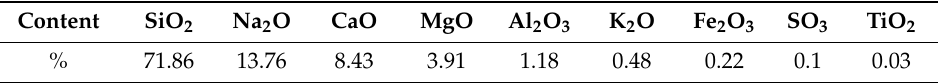
Table 1. Chemical composition of glass microspheres.